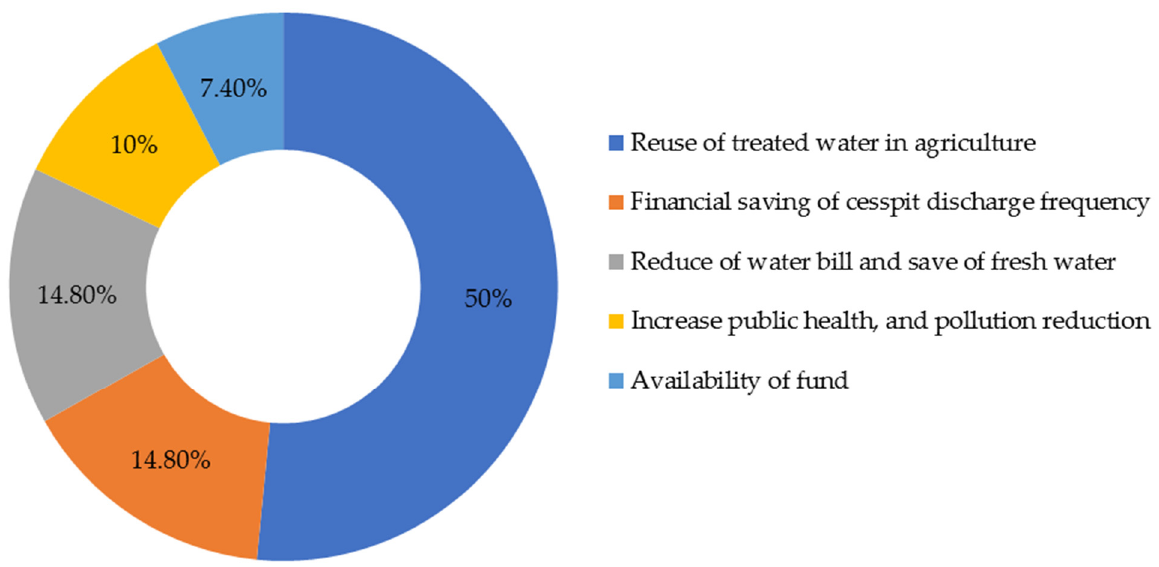
Figure 6. Drivers for accepting onsite GWTPs by the cesspits’